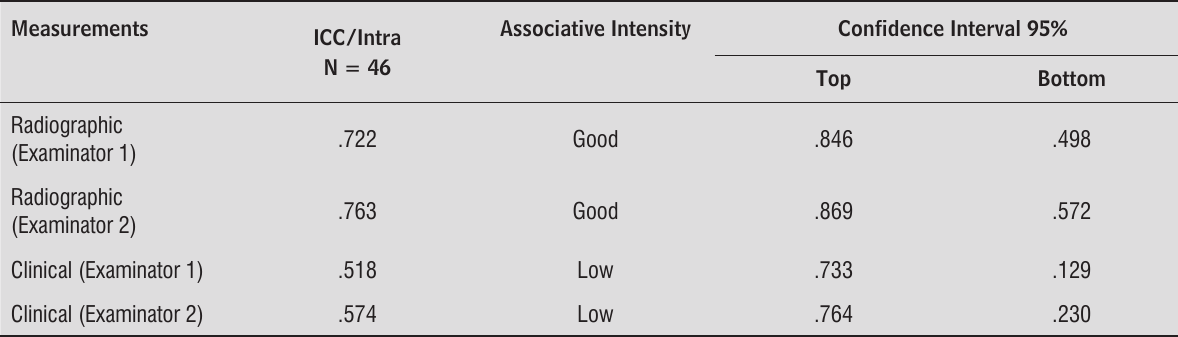
Table 2 - Intra-examiner reliability obtained through the ICC